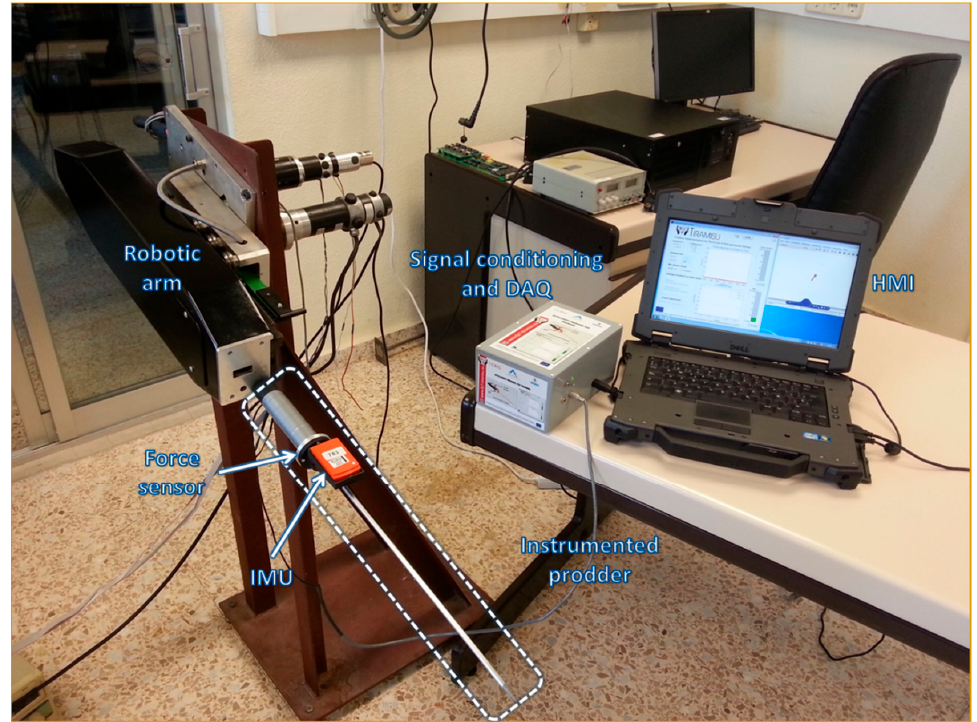
Figure 10. Intelligent feedback prodder installed in the robotic arm for the second part of the experimentation.